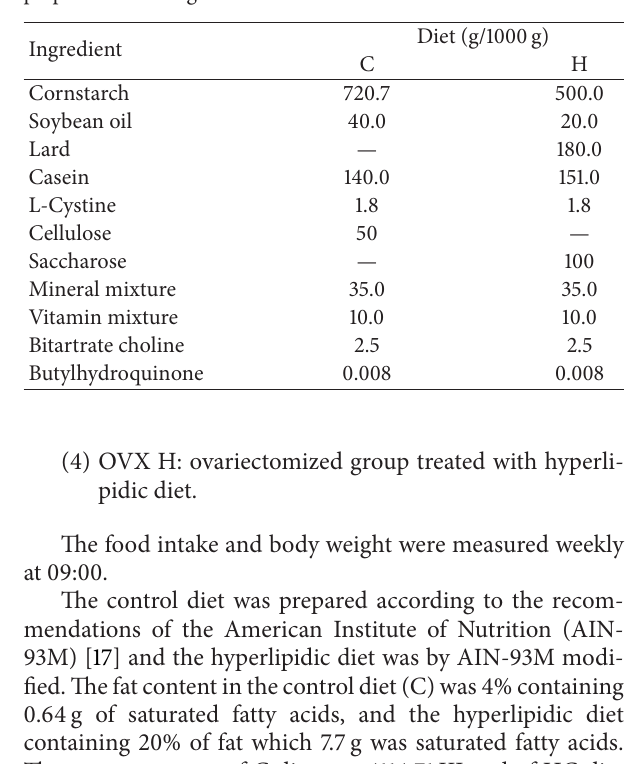
Table 1: Composition of the control (C) hyperlipidic (H)